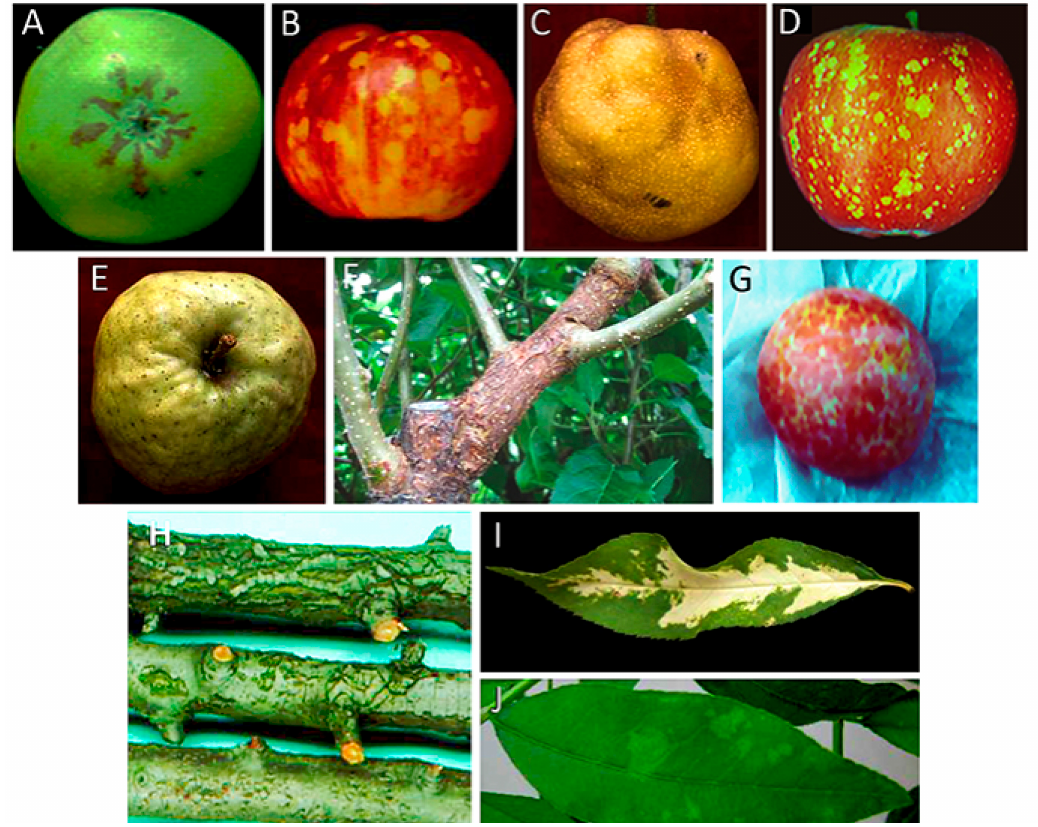
Figure 1. ( A ) Symptoms induced by ASSVd on apple fruits cv. ‘Indo’ (Courtesy of J.C. Desvignes); ( B ) symptoms induced by ASSVd on apple fruits cv. ‘Starkrimson’ (Courtesy of J.C. Desvignes); ( C ) symptoms of pear fruit dimple induced by ASSVd on Japanese pear; ( D ) symptoms induced by ADFVd on apple fruits cv. ‘Starkrimson’ (Courtesy of J.C. Desvignes); ( E ) symptoms of fruit crinkle on apple fruit cv. ‘Orin’ induced by AFCVd; ( F ) symptoms of blister bark on cv. ‘Nero 26 (cid:48) induced by AFCVd (Courtesy of D. Ito); ( G ) symptoms of dapple induced by HSV in plum (Courtesy of H.L. Sänger); ( H ) symptoms induced by PBCVd in pear cv. ‘A 20 (cid:48) (Courtesy of J.C. Desvignes); ( I ) symptoms of severe albinism (calico) induced by PC-40 variant of PLMVd in leaves of the peach seedling GF-305; ( J ) symptoms of green mosaic induced by gds3 variant of PLMVd in leaves of the peach seedling